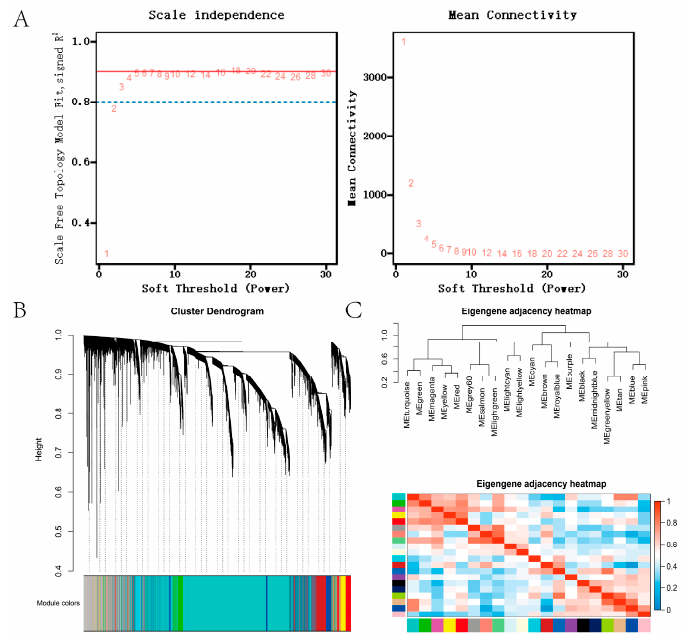
Figure 3. Scale independence of co-expression and Mean connectivity of co-expression. ( A ) Screening of soft thresholds. ( B ) Cluster dendrogram. ( C ). Eigengene dendrogram of modules and Eigengene adjacency heatmap.